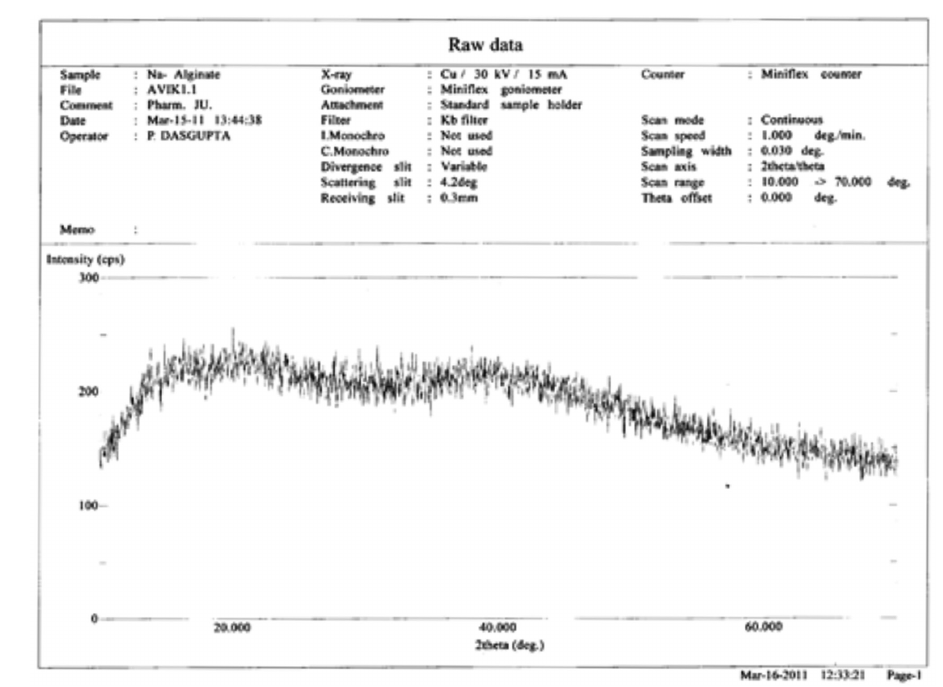
FIGURE 9 (b) - X-ray diffraction analysis of sodium alginate alone.